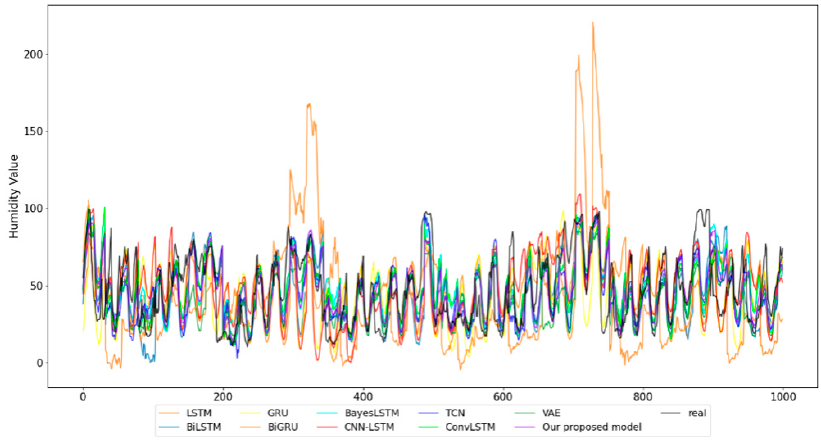
Figure 9. Plots of prediction results of different models on the humidity dataset.